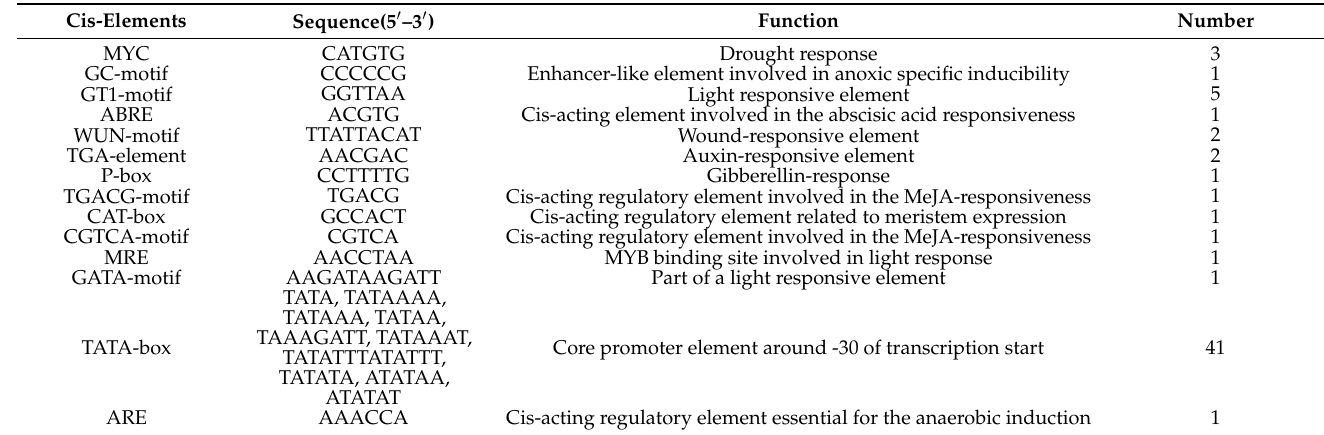
Table A2. Cis-acting elements of the SbSGT1 promoter